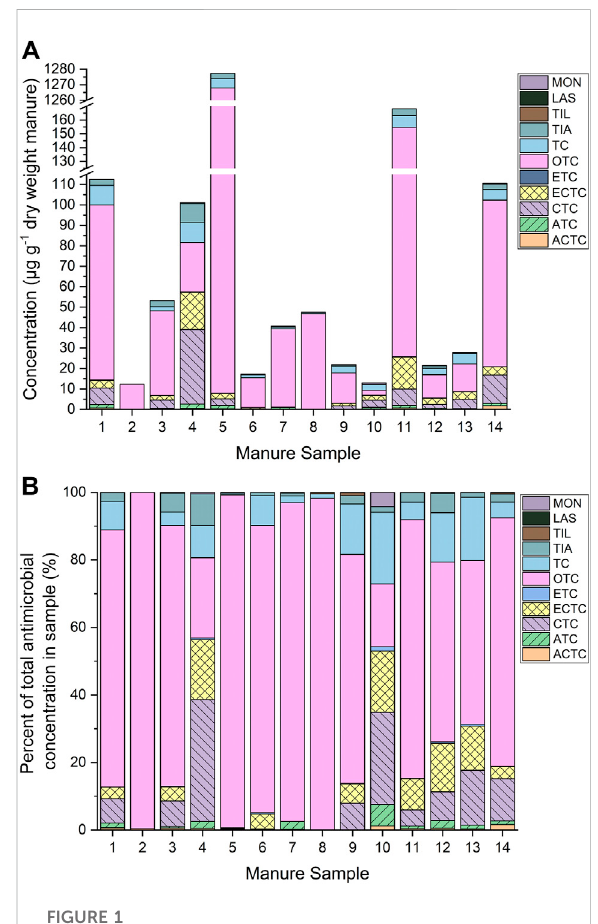
FIGURE 1 (A) Antimicrobial and transformation product concentrations and (B) antimicrobial and transformation product pro fi les of 14 swine manure samples from Iowa farms, analyzed by liquid chromatography tandem mass spectrometry (LC-MS/MS). Antimicrobials: Anhydrochlortetracycline (ACTC), anhydrotetracycline (ATC), chlortetracycline (CTC), epichlortetracycline (ECTC), epitetracycline (ETC), oxytetracycline (OTC), tetracycline (TC), tiamulin (TIA), tilmicosin (TIL), lasalocid (LAS), and monensin